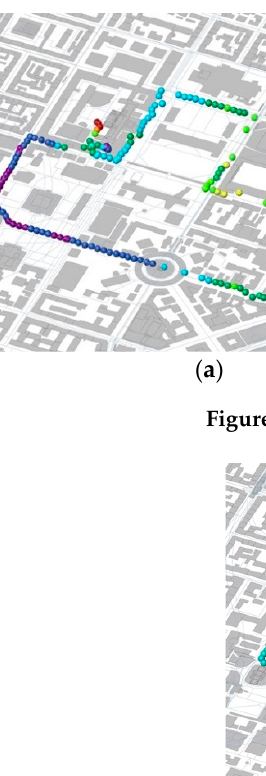
( b ) Figure 27. ( a ) Relative humidity (%); ( b ) wind speed (m/s). ( a ) ( b ) Figure 28. ( a ) Solar radiation (w/m 2 ); ( b ) noise level maps (dB).